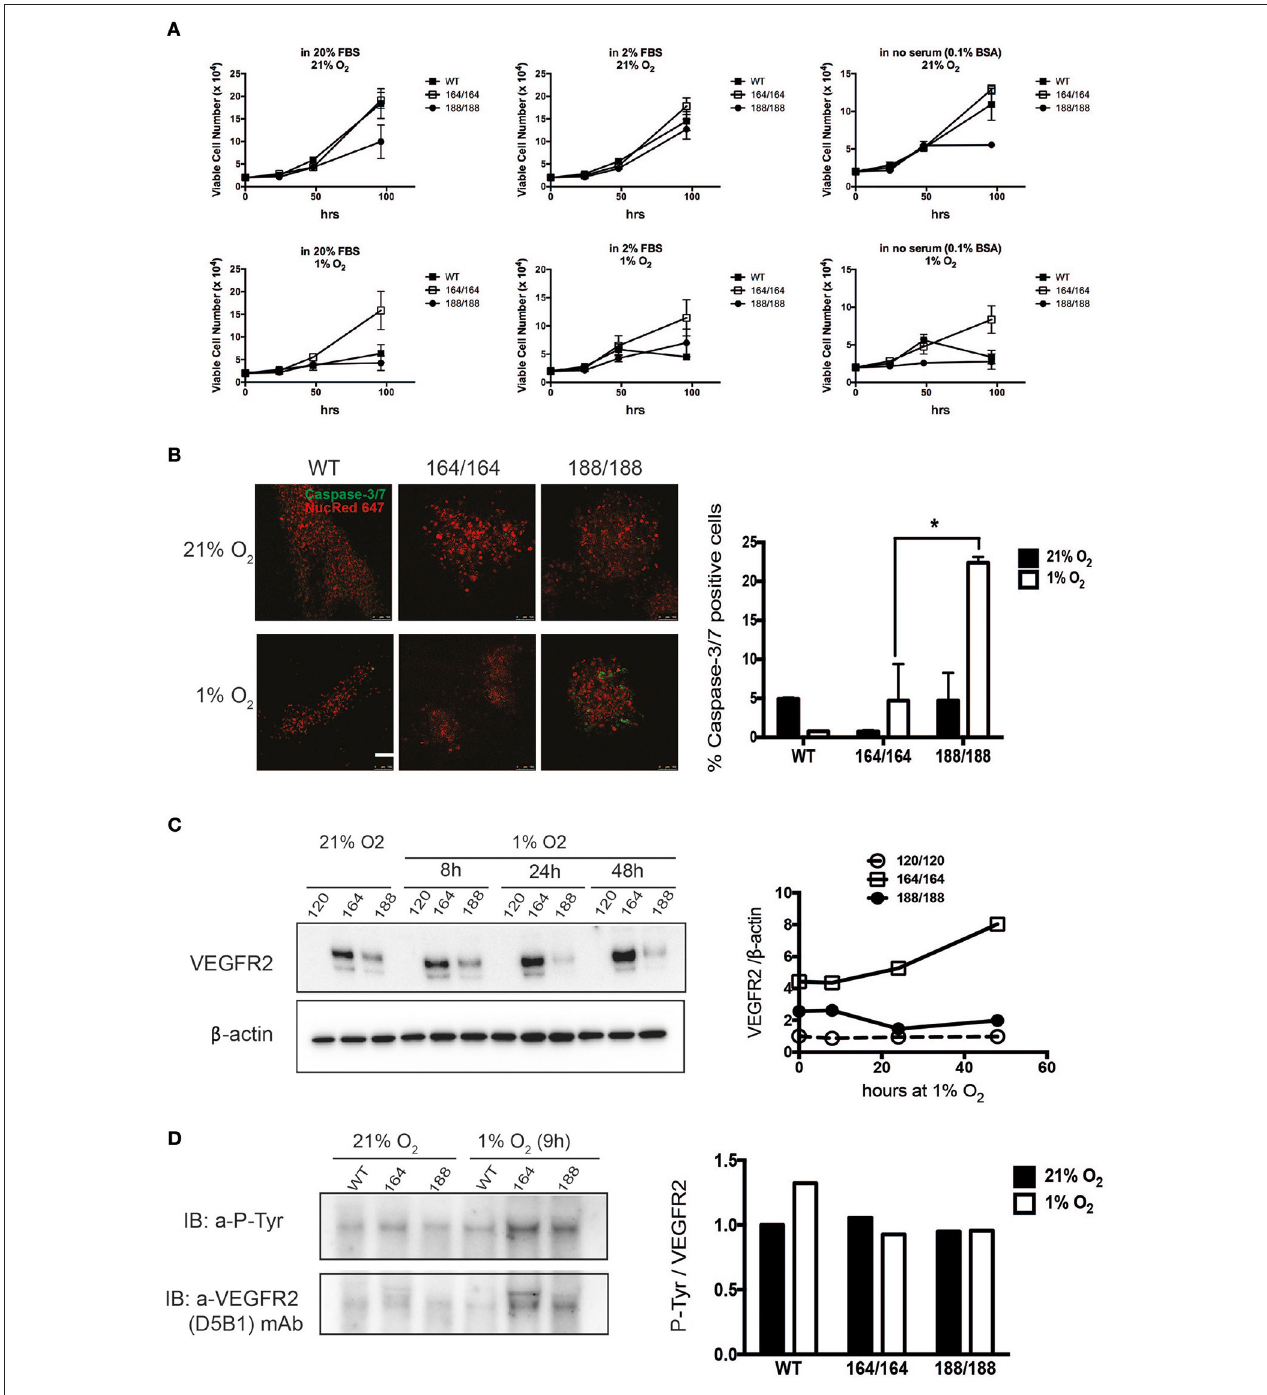
FIGURE 1 | Contribution of specific VEGF isoforms to endothelial cell viability and autocrine signaling. (A) Endothelial cell viability was measured in wild-type (WT) endothelial cells and cells expressing each of the VEGF isoforms 164 or 188, in normoxia (21% O 2 , top panels) and hypoxia (1% O 2 , bottom panels), for 96 h. The culture media containing 20% FBS (high serum), 2% FBS (low serum), or 0.1% BSA (no serum) were replaced at the time points of 24 h after cell plating. Data shown are average cell number (per well) ± SEM ( n = 3); three wells, each containing cells from 2 to 3 mice. (B) EC of different genotypes were stained for Caspase 3/7 to assess relative levels of apoptosis in normoxia (top) and after 48 h of hypoxia (bottom), scale bar, 100 µ m. Right Panel shows ratio of caspase-3/7-positive cells out of total cells (caspase-3/7-positive and NucRed Live 647-positive cells). Data represents average ± SEM ( n = 3); three fields, each containing cells from 2 animals, * P < 0.05. (C) VEGFR2 protein abundance was assessed by western blot of whole cell extracts (left). Quantification is shown in the panel on the right. (D) Activation of VEGFR2 was assessed by immunodetection of P-Tyr in total VEGFR2 protein obtained by immunoprecipitation (IP); representative blot shown on the left and quantification data on the